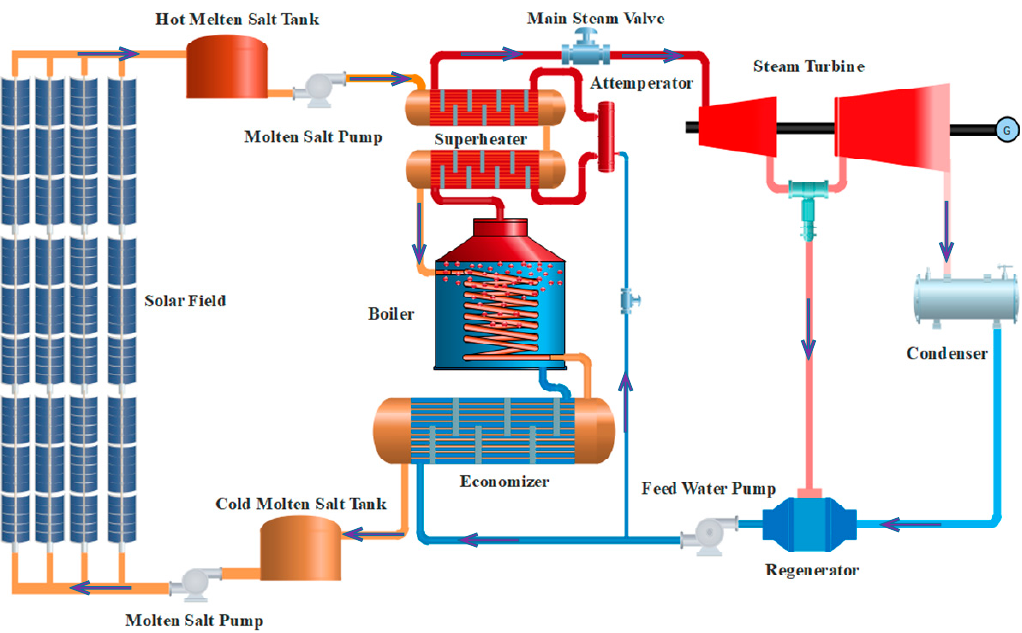
Figure 1. System configuration of the concentrating solar power (CSP) plant with two-tank direct thermal energy storage (TES) (the arrows represent the fluid flow direction).